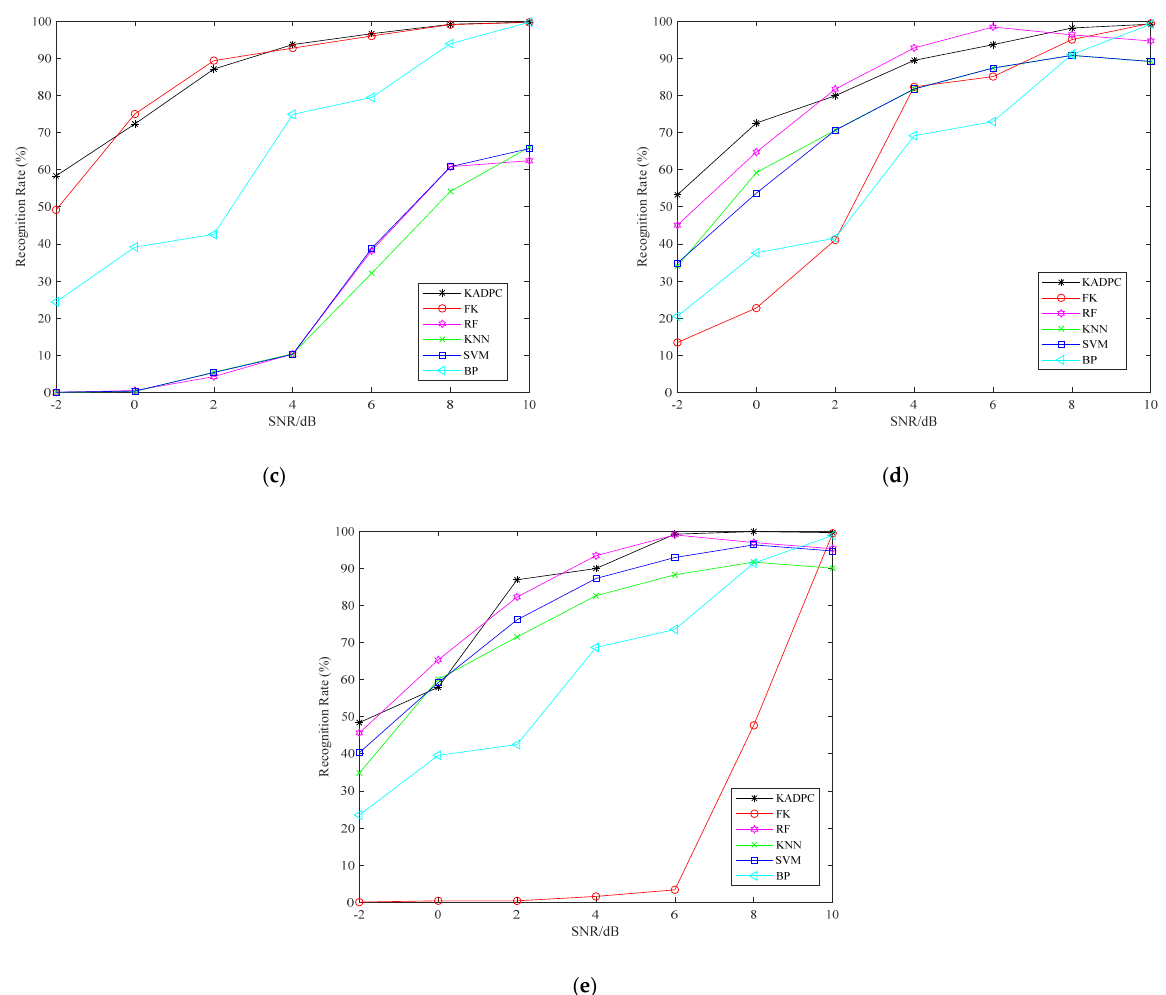
Figure 5. The Recognition rate of different signals. ( a ) BPSK; ( b ) QPSK; ( c ) 8PSK; ( d ) 16QAM; ( e ) 32QAM.